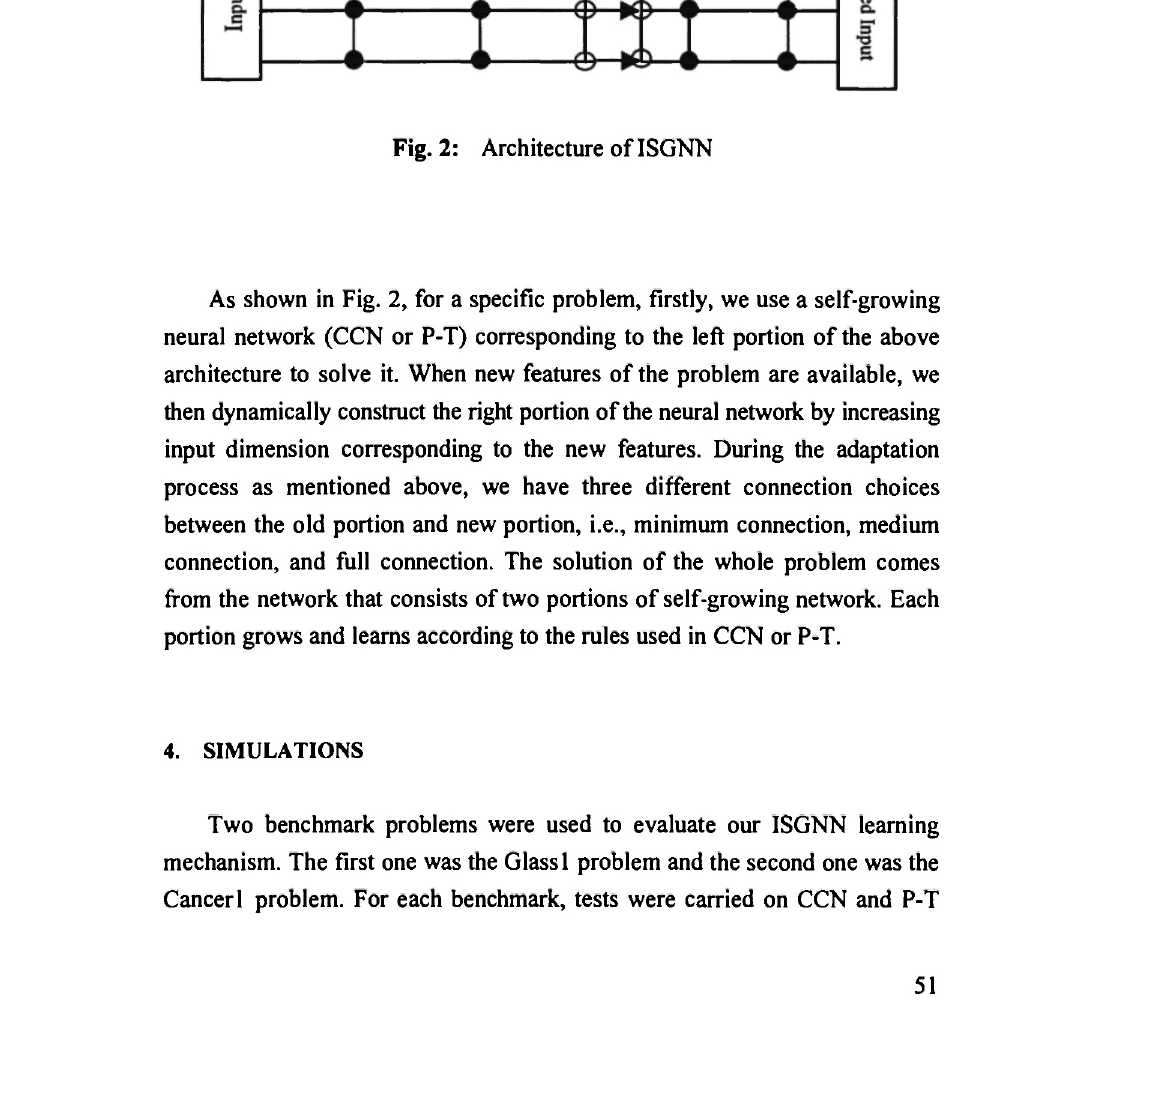
Fig. 2: Architecture of